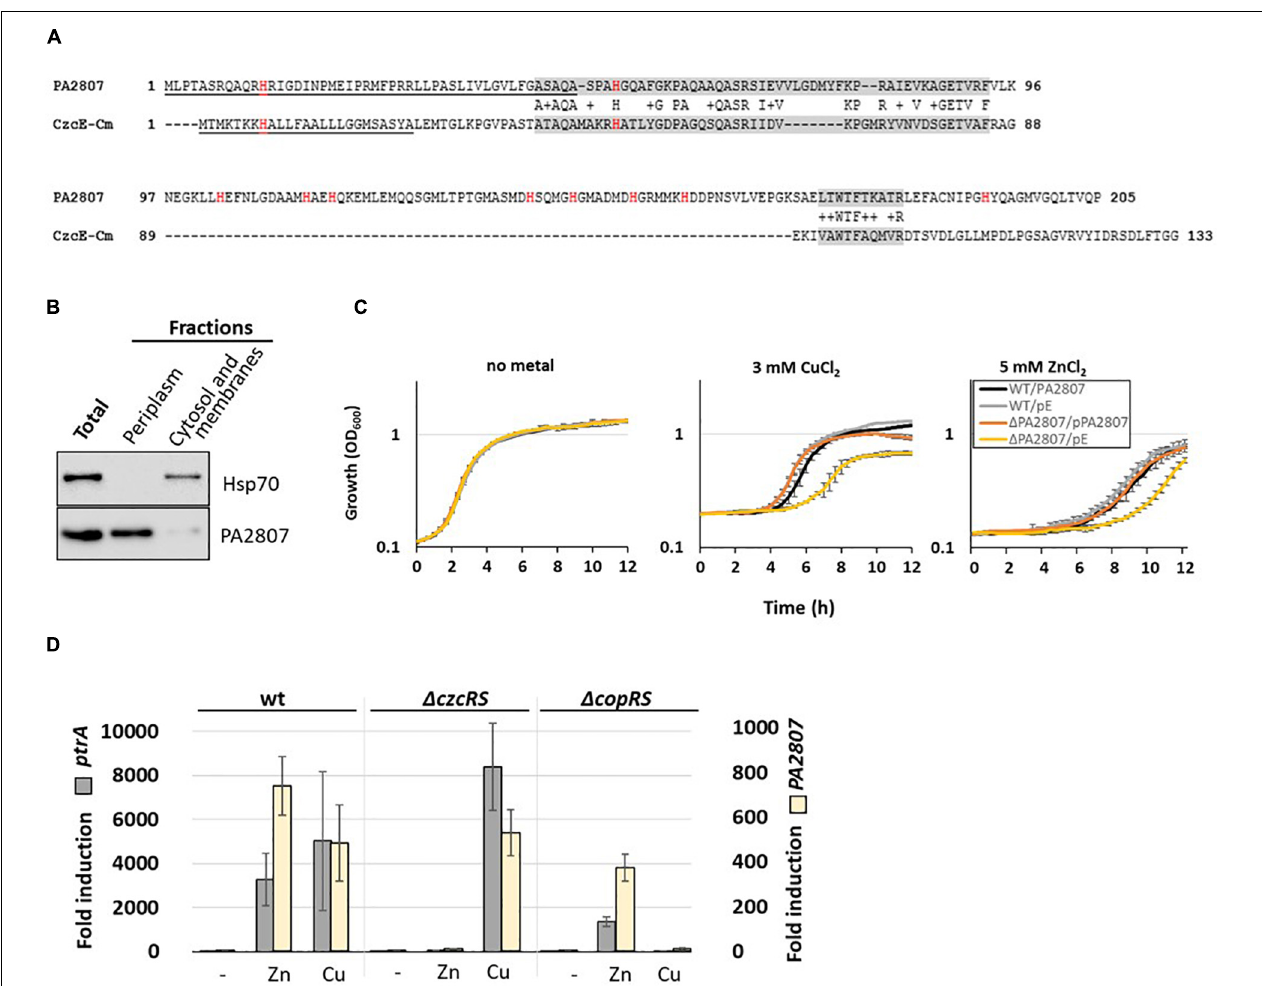
FIGURE 3 | PA2807 encodes a CzcE-like protein. (A) Primary sequence alignment of PA2807 and CzcE from Cupriavidus metallidurans. The transit peptide is underscored and histidine residues are indicated in red. The two boxes of similarity are labeled in gray. (B) Immunoblot analysis of PA2807 localization. A culture of WT P. aeruginosa containing the 6His tagged version of the PA2807 gene and its promoter on the pME6001 plasmid was induced for 2 h with 2 mM CuCl 2 . 25 µ g of total protein, and an equal volume (of 25 µ g of protein) of periplasmic and cytosolic-membrane fractions was separated on a 4–12% SDS PAGE. Blots were exposed to anti-6His and anti-Hsp70 (loading and cytosolic control) antibodies. (C) Growth curves of WT P. aeruginosa and the (cid:49) PA2807 mutant carrying the empty IPTG-inducible pMMB66EH plasmid or the pMMB66EH- PA2807 plasmid. Strains were cultivated in LB medium in the absence or presence of 3 mM CuCl 2 or 5 mM ZnCl 2 with 0.1 mM IPTG. (D) Fold induction of ptrA and PA2807 mRNA analyzed using qRT-PCR on RNA extracted after 2 h of growth in presence of 2 mM ZnCl 2 or 2 mM CuCl 2 as indicated. Error bars represent the standard deviations of three independent